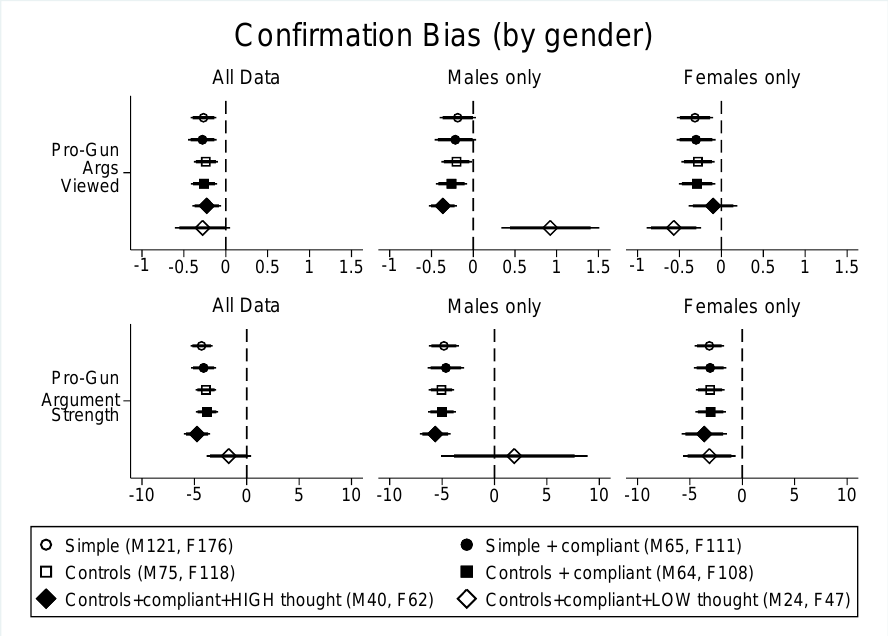
Figure 1. Impact of Liberal Score on # PRO-GUN-RIGHTS CLIPS viewed (upper panels) and on perceived strength of pro-gun-rights arguments (lower panels). Notes: All models account for sample selection using the inverse probability weight ( IPW ) correction—see Table A1 for selection equation estimates. One or more control measures were not captured on 4 individuals. Models conditioned on sleep compliance do not include well-rested (WR) participants with < 405 min nightly sleep (actigraphy measured) or sleep-restricted (SR) participants with > 375 min nightly sleep (and also excludes participants who failed the attention check question). HIGH Thought refers to those responding ≥ 65 on a [0, 100] scale of how much thought they had put into the issue of gun control. Thin (thick) lines represent the 95% (90%) confidence intervals. See Tables 2–5 for full results of all models other than binary regressions for the separate male and female subsample models (where the only independent variable was Liberal Score and whose coe ffi cient estimate is shown